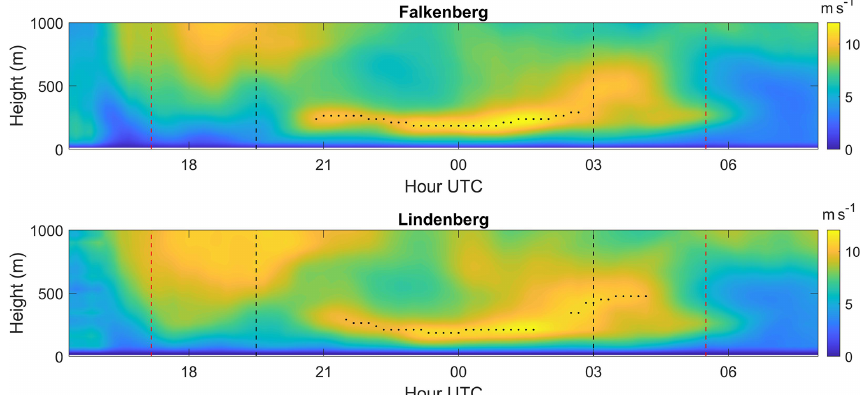
Figure 9. Absolute wind speed (ms − 1 ) during the night between 27 and 28 June 2020 in Falkenberg and Lindenberg as a function of time and height a.g.l. The black dots mark the NLLJ core and dashed black (red) lines the time of 0 ◦ (20 ◦ ) solar elevation. Table 5. Total number and percentage of nights with at least one NLLJ event and the number of nights with NLLJs classified by their duration. The percentage for the four latter columns are calculated from the number of all NLLJ nights.